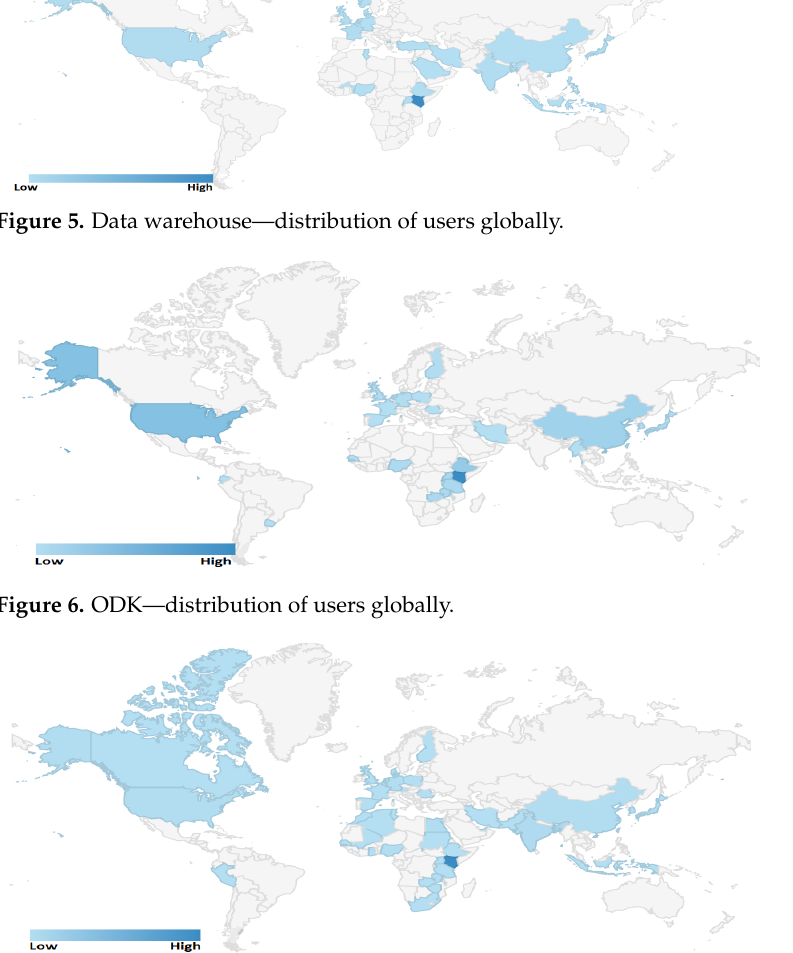
Figure 7. REDCap—distribution of users